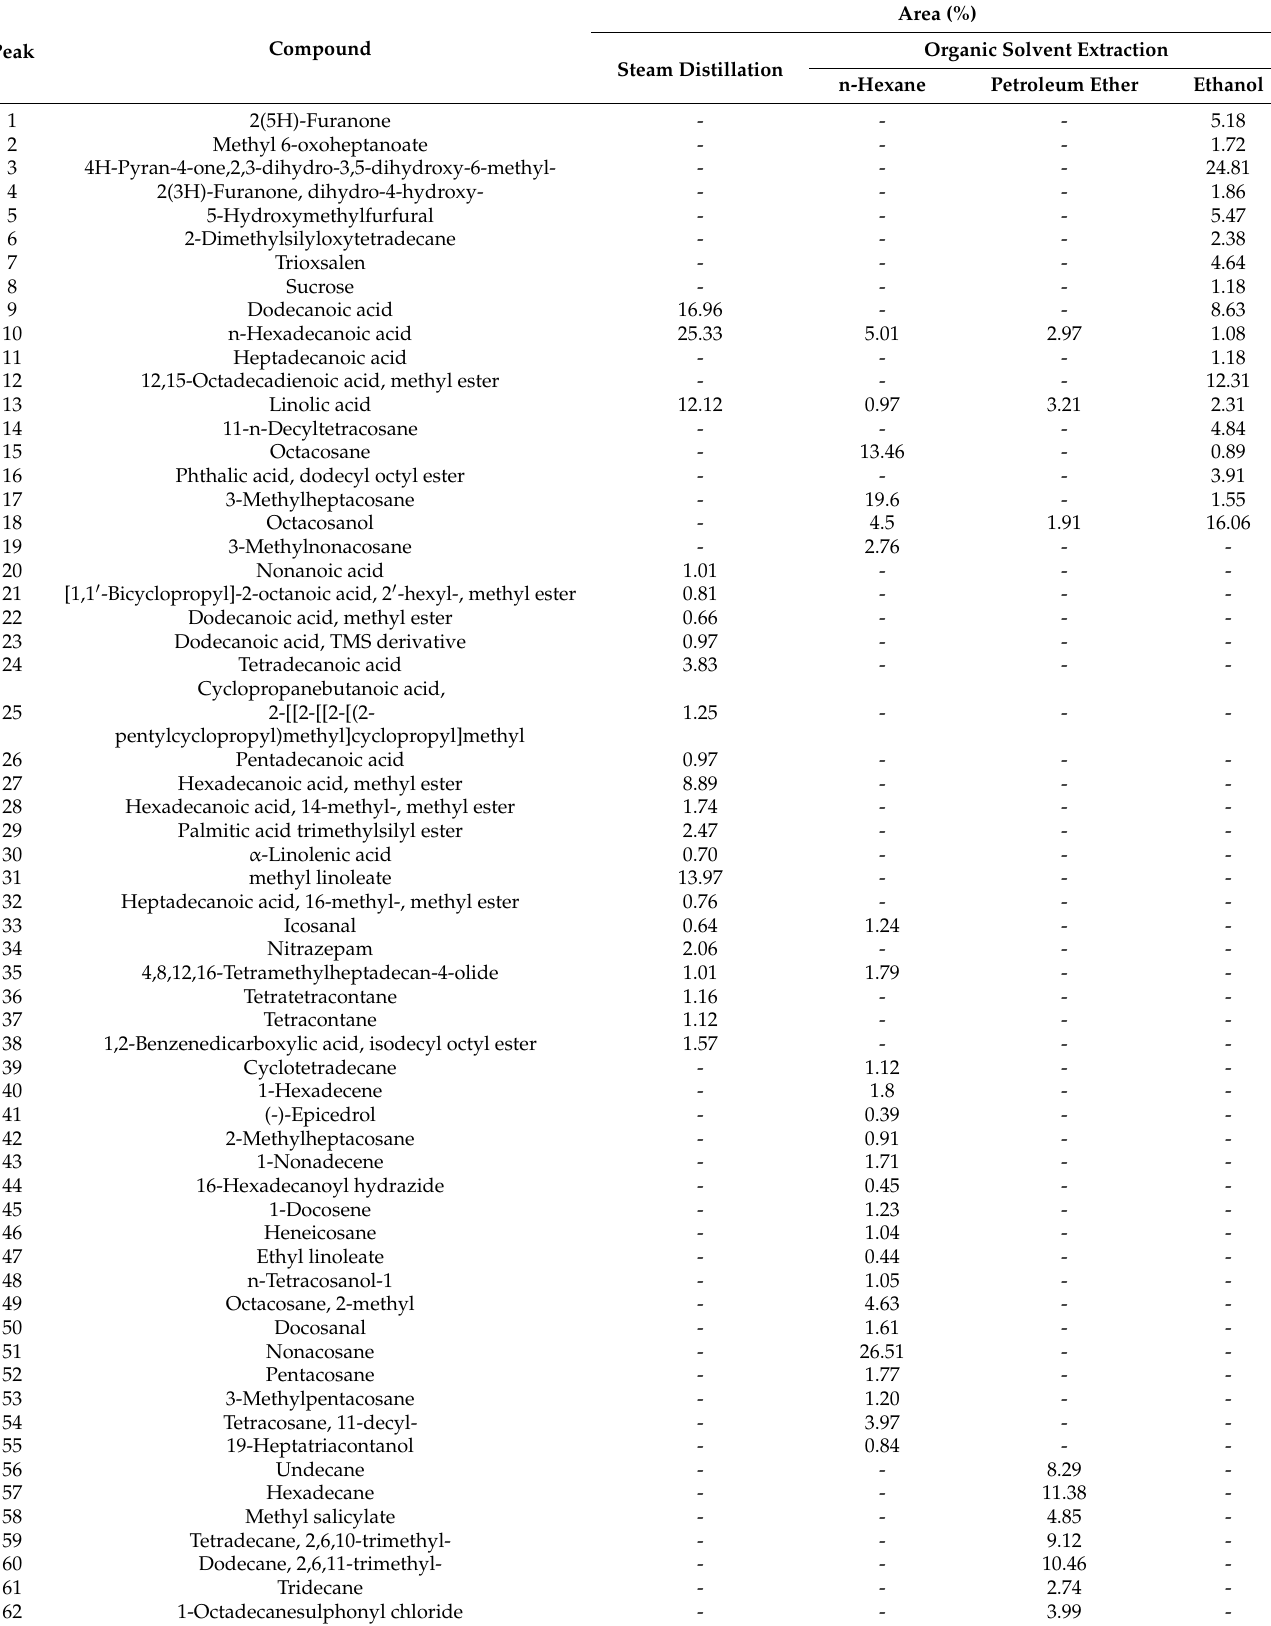
Table 2. Results of GCMS analysis of saffron petal extracts obtained by the four extraction